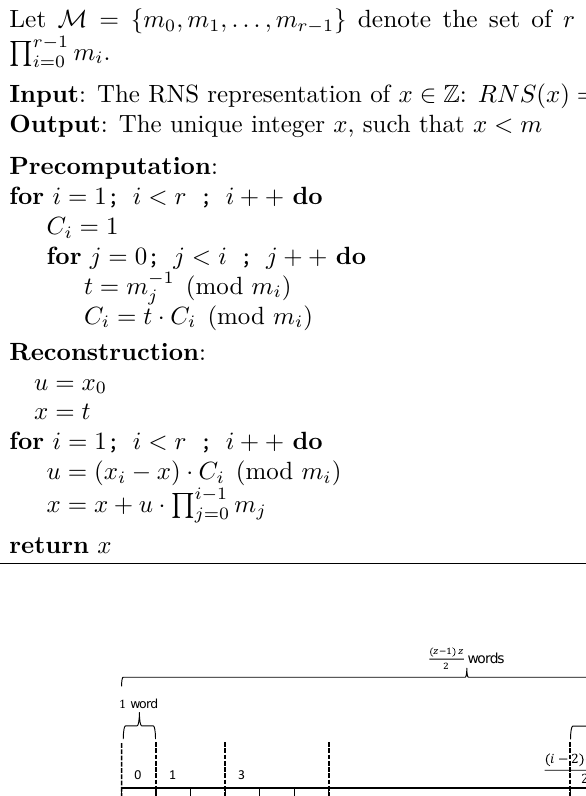
Algorithm 4 Garner’s CRT-reconstruct using mixed-radix system